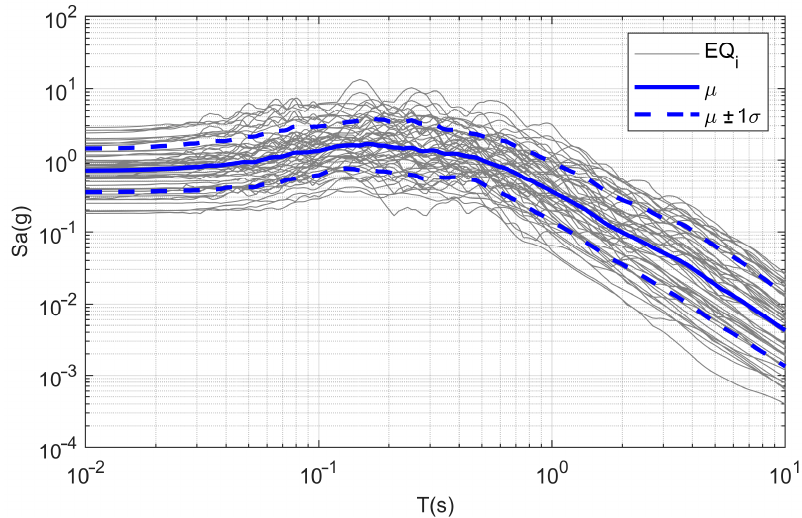
Figure 6. Illustration of the spectral variability of the input ground motions in terms of elastic 5%-damped pseudo spectral accelerations.